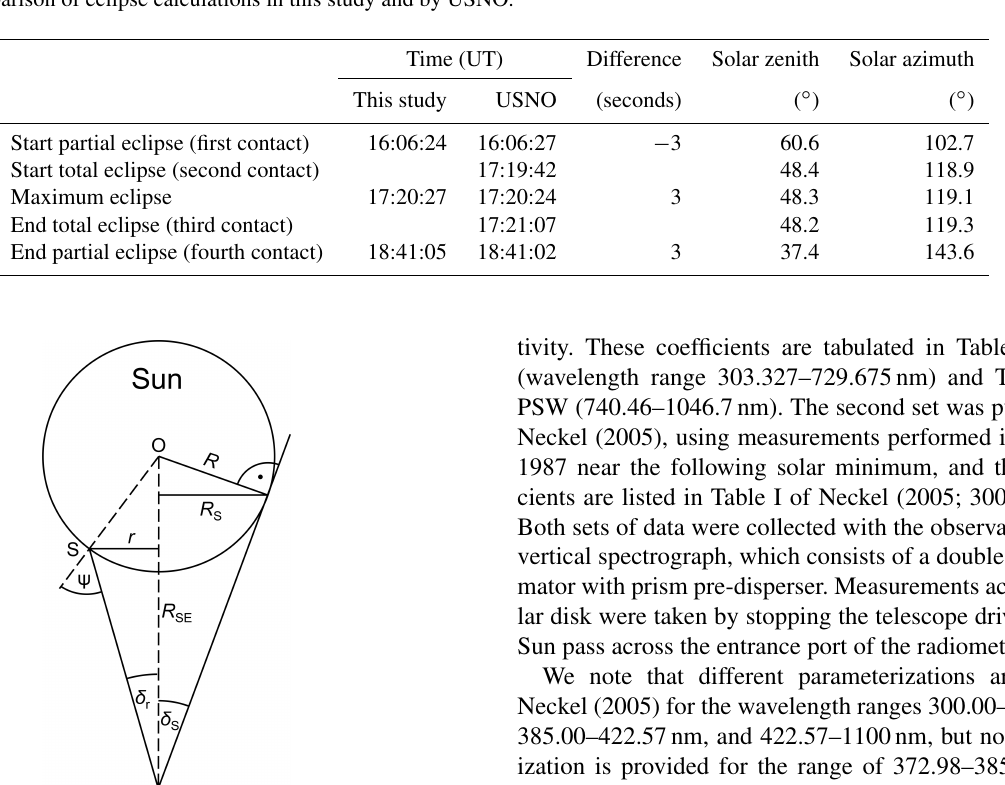
Table 1. Comparison of eclipse calculations in this study and by USNO.